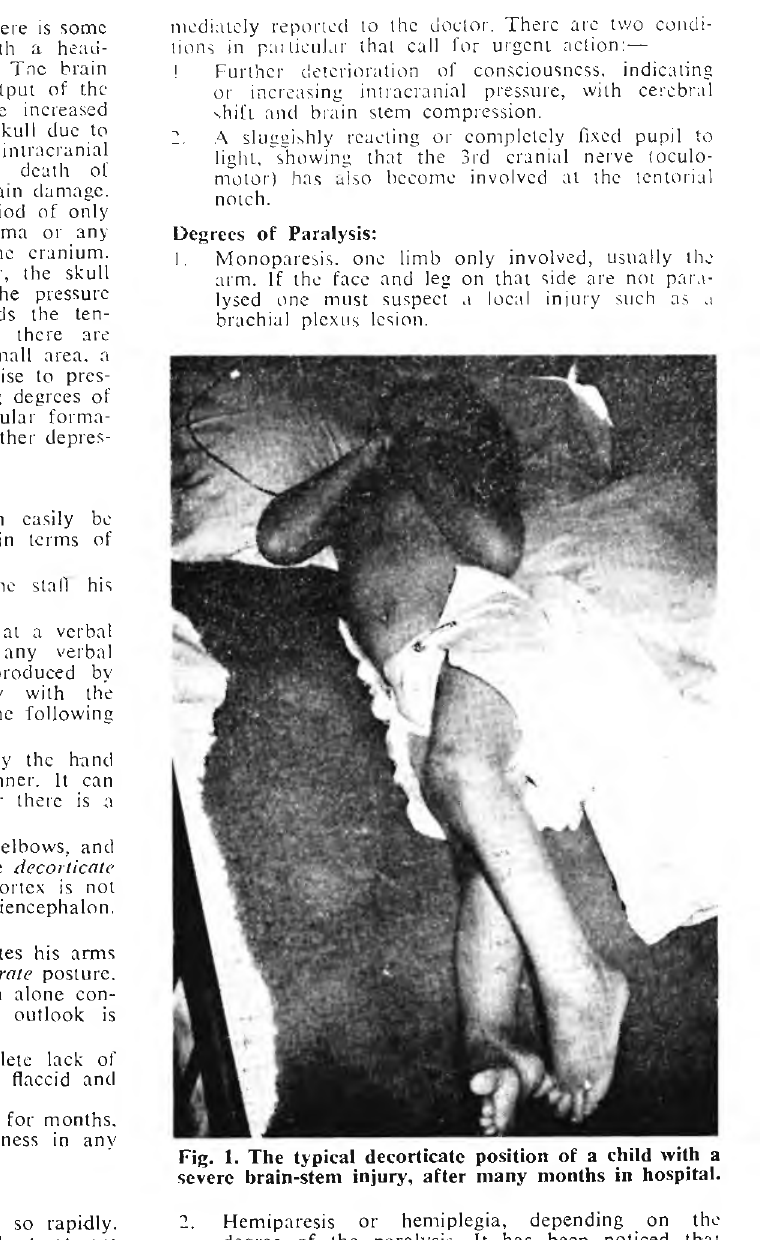
Fig. 1. The typical decorticatc position of a child with a severe brain-steni injury, after many months in hospital. 2. Hemiparesis or hemiplegia, depending